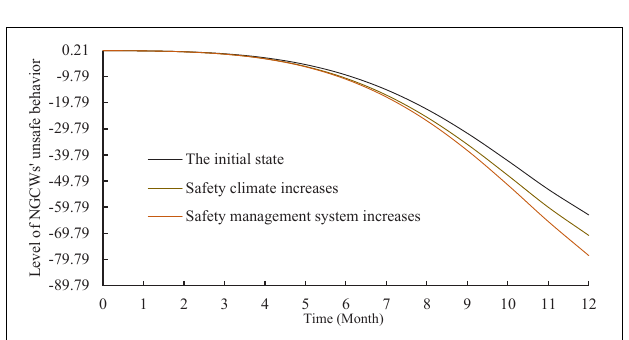
FIGURE 5 | Simulation of the effect of motivation for unsafe behavior on unsafe behavior.